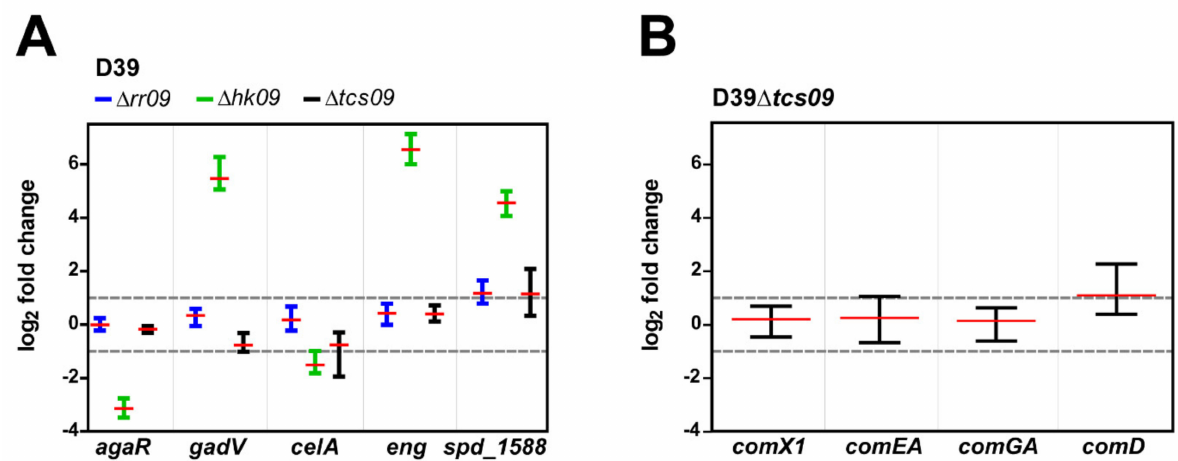
Figure 3. Differential gene expression in S. pneumoniae D39 and isogenic tcs09 -mutants using qPCR. Pneumococci were grown in CDM with glucose to OD 600nm of 0.6; the RNA was isolated and reverse transcribed into cDNA. As indicated by dotted lines, log 2 fold changes < − 1 and > 1 were set as significant for differential gene expression. ( A ) Differential gene expression of agaR , gadV, celA , eng , and spd_1588 . ( B ) Differential gene expression of the competence genes comX1 , comEA , comGA , and comD . The log 2 fold changes of differential gene expression in four replicates and their means are